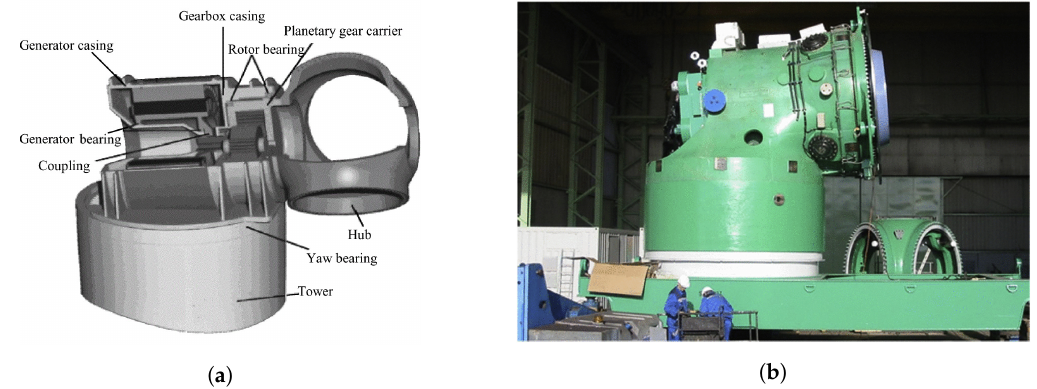
Figure 2. The multibrid concept: ( a ) Schematic illustration [12], ( b ) The AREVA Multibrid M5000 5 MW wind turbine nacelle